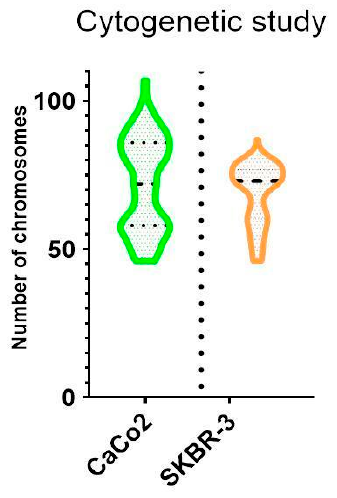
Figure 3. Violin plot showing chromosome distribution of both cell lines. The mean number of chro- mosomes for Caco2 was 72, although two modal karyotypes of 58 and 86 chromosomes were ob- served. A unique modal karyotype of 76 chromosomes for SKBR3 was observed.